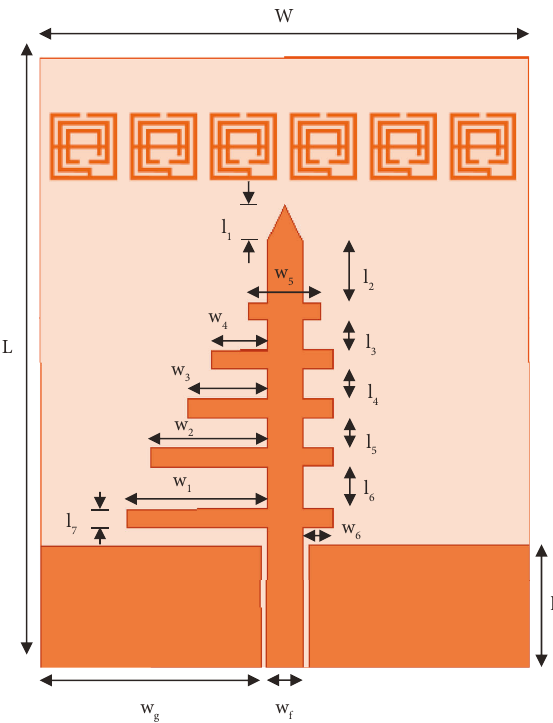
Figure 6: Geometrical dimensions of the proposed PLPA.